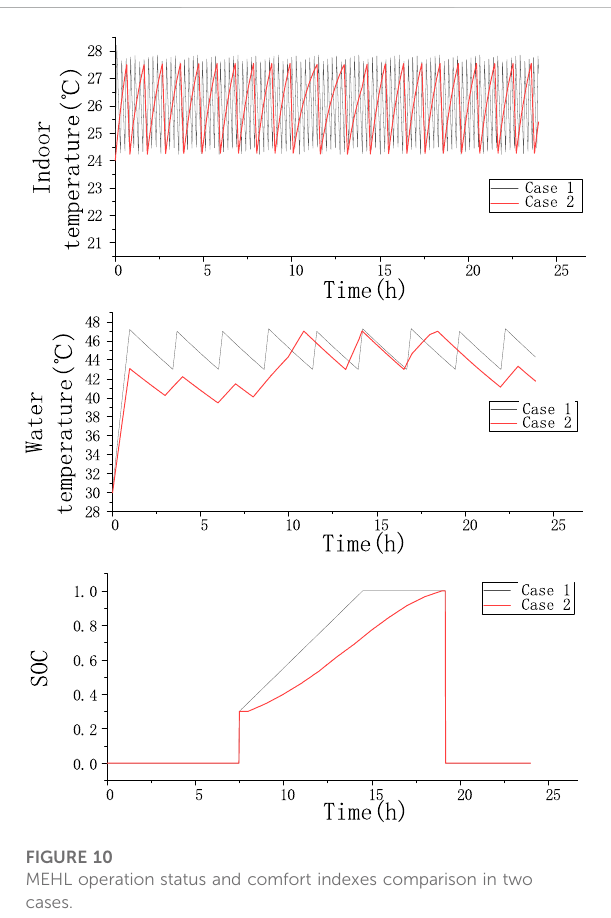
FIGURE 10 MEHL operation status and comfort indexes comparison in two